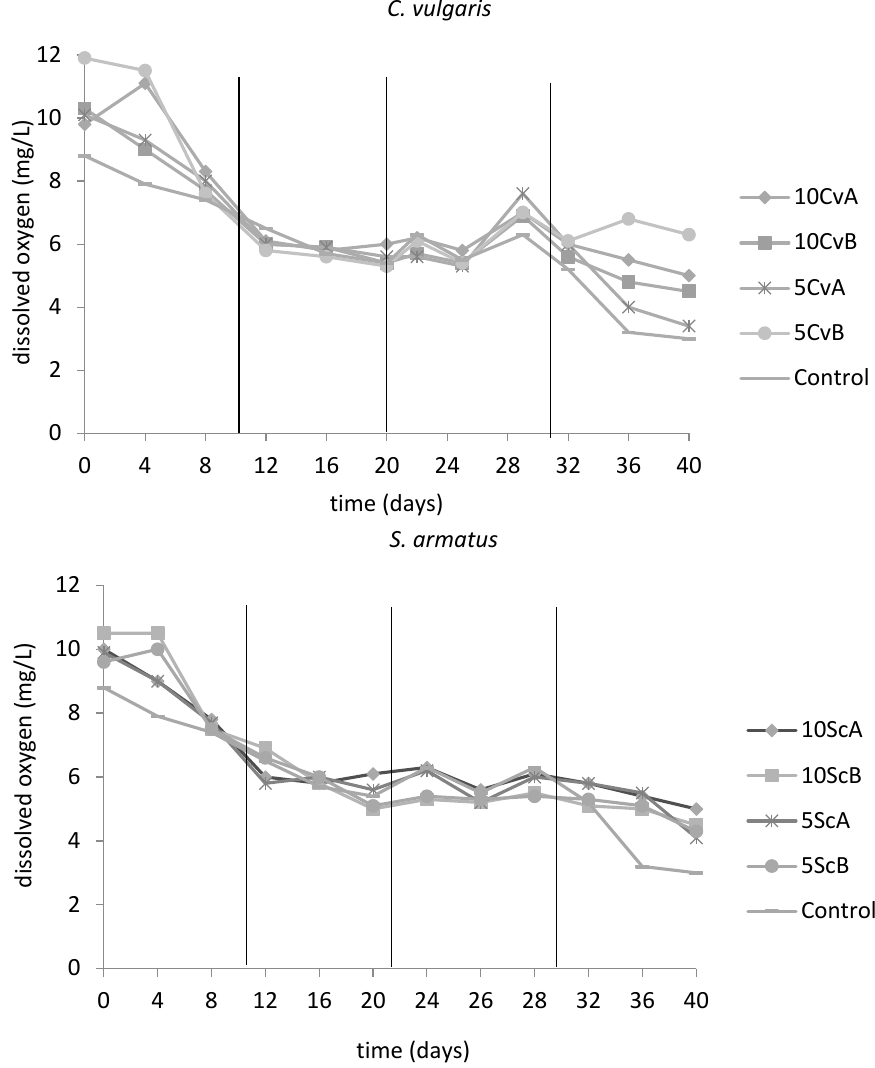
Figure 4. Oxygen concentration values observed during the repeated fed-batch culture cultivation of microalgae. The lines indicate the days when the culture was fed with a new dose of wastewater. From the thirtieth day after replacing the last portion of wastewater the dissolved oxygen concentration began to decrease in all samples, reaching the lowest values in the range of 3.3–6.3 mg/L observed in the last days. This was unfavourable for microalgae breeding.